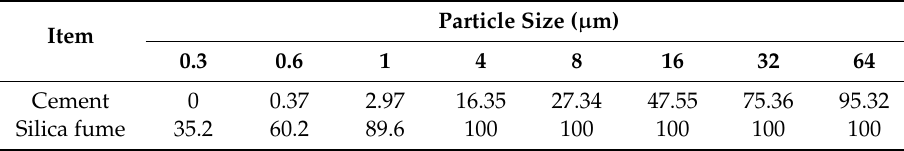
Table 3. Cumulative passing percentage of filler material